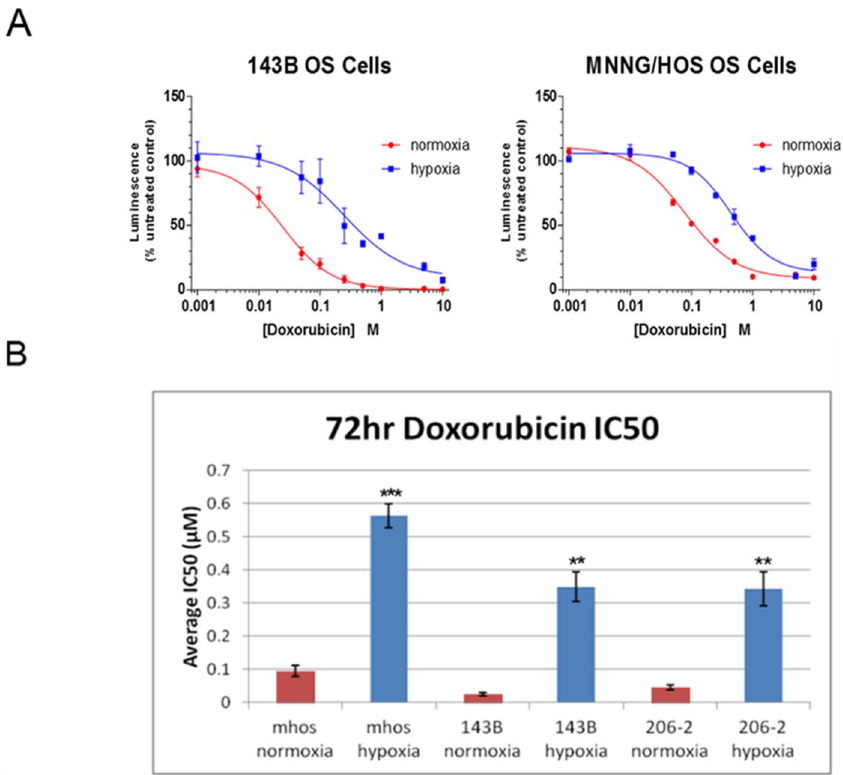
Figure 4. Hypoxia results in chemoresistance of human OS cells to doxorubicin. A, Dose-response curves for the 143B and MNNG/HOS (mHOS) cell lines treated with increasing concentrations of doxorubicin under normoxic and hypoxic conditions (72 hour, 0.5% O 2 ). Luminescence (viability) was determined as a percent of untreated control (0 m M doxorubicin). B, Average half maximal inhibitory concentration (IC 50 ) values were obtained from the dose-response curves and compared between normoxic and hypoxic conditions for the cell lines MNNG/HOS (mHOS), 143B, and a patient-derived OS cell line, 206-2. Asterisks indicate statistical significance (**p , 0.01, ***p , 0.001).